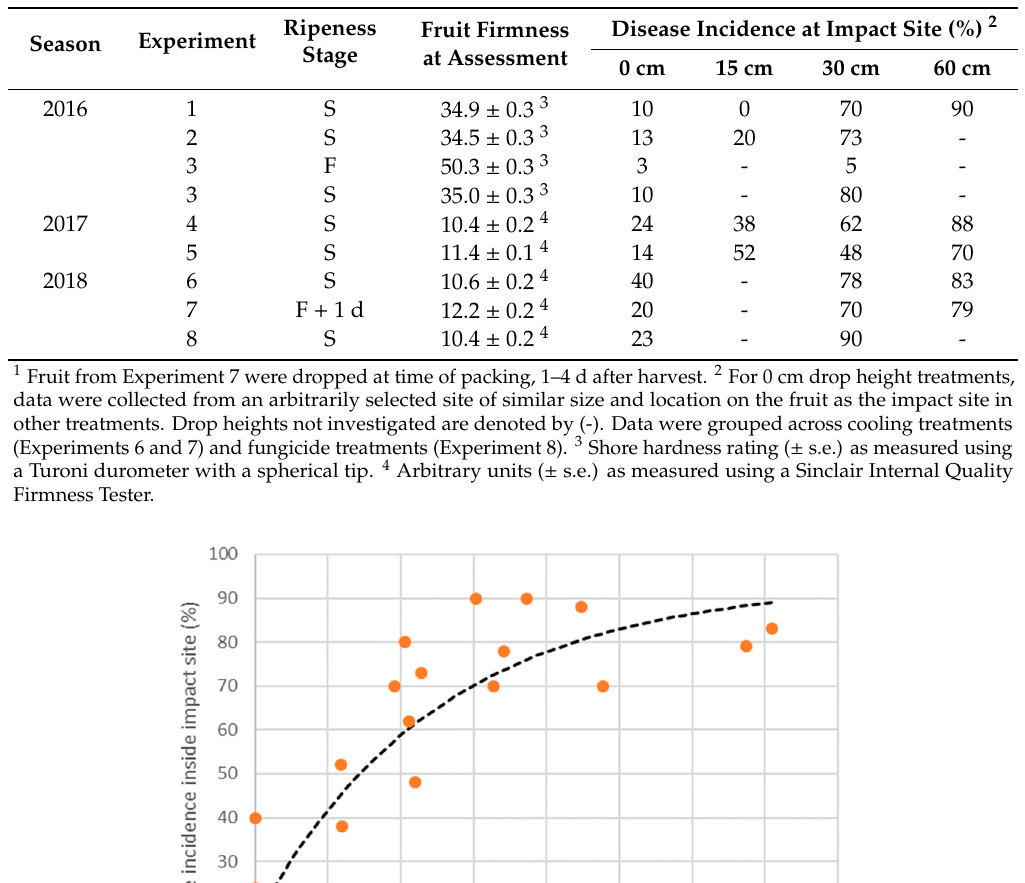
Table 3. Disease incidence at the impact site in ‘Hass’ avocado fruit dropped from a height of 0, 15, 30 or 60 cm on the day of harvest 1 and assessed at soft-ripe stage (S), firm-ripe stage (F) or 1 day after reaching firm-ripe stage (F + 1 d).